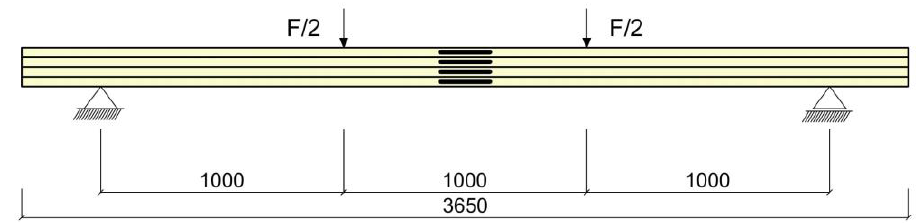
Figure 1. Load case diagram.